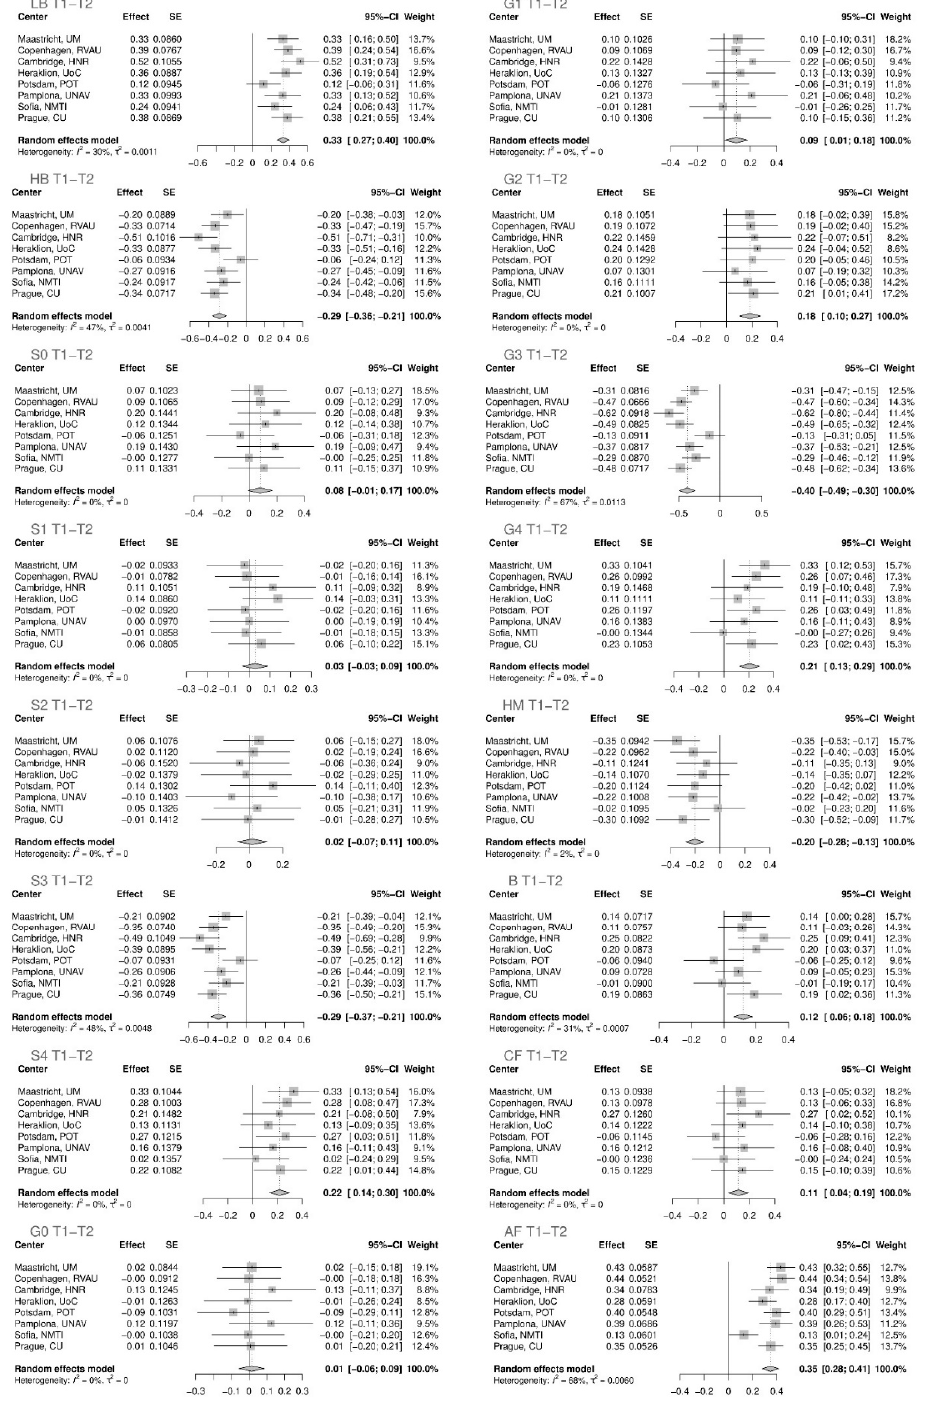
Figure 1. The effect of a low-calorie diet on plasma N-glycome composition in the first time period of eight weeks (T1–T2). Changes in plasma protein glycome composition after performing meta-analysis for all the centers are shown. SE—standard error; 95% CI – 95% confidence interval; T1—time point 1; T2—time point 2; T3—time point 3; LB—total low branching glycans; HB—total high branching glycans; S0—total neutral glycans; S1—total monosialylated glycans; S2—total dis- ialylated glycan; S3—total trisialylated glycans; S4—total tetrasialylated glycans; G0—total